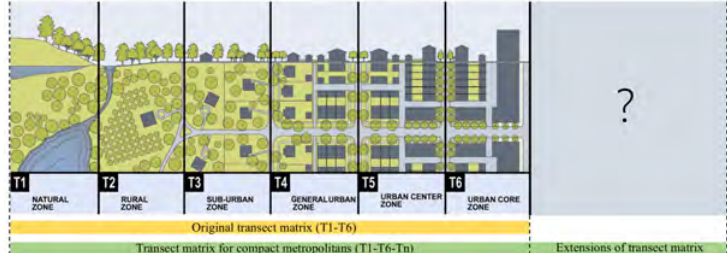
Figure 3. Extensions of the original transect matrix of Form-Based Code